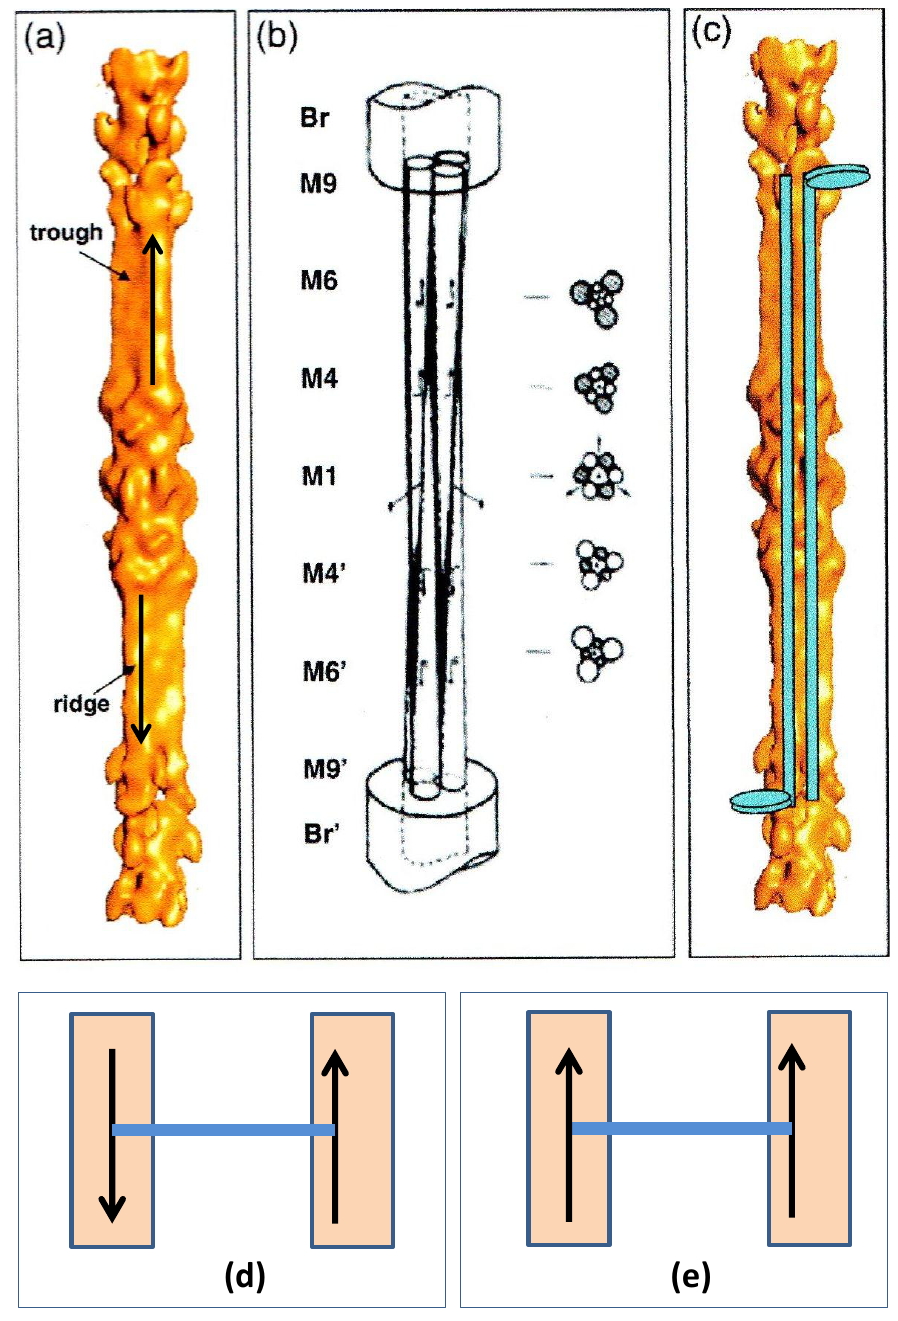
Figure 10. ( a ) 3D reconstruction of the myosin filament bare zone and its interpretation: ( b ) in terms of three overlapping conical rod shaped subfilaments; and ( c ) in terms of antiparallel groups of myosin rods. (From [30] with permission from Elsevier). ( d ) Up to down interaction at M4 as in bony fish muscle; ( e ) up to up or down to down interactions at M4 as in superlattice